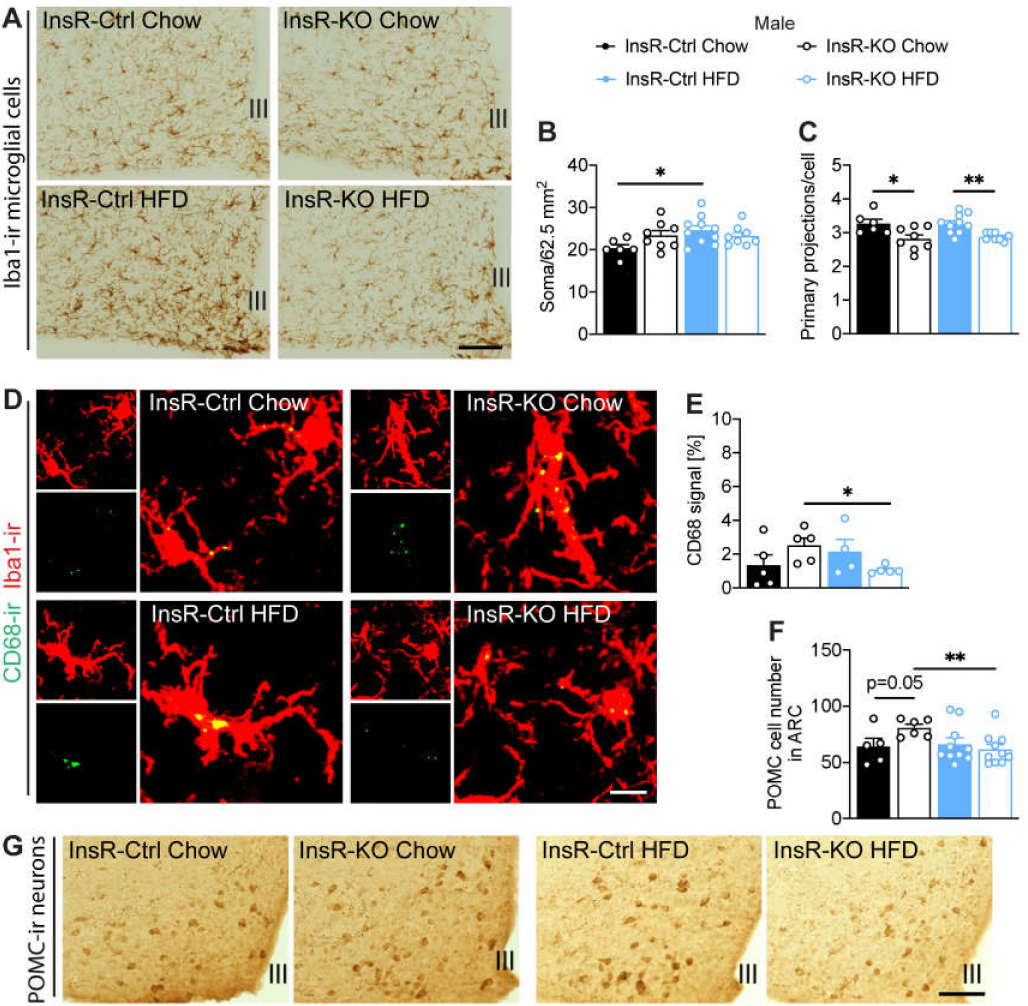
Figure 5. Loss of microglial InsR in male mice leads to impaired microglial morphology, altered phagocytic capacity, and changes in POMC cell number in the arcuate nucleus. ( A ) Iba1-ir microglia in the arcuate nucleus, Iba1-ir ( B ) soma number, and ( C ) primary projections ( n = 6–10). InsR-KO mice had lower primary projections compared to InsR-Ctrl mice, irrespective of diet. ( D , E ) CD68-ir co-localization with Iba1-ir microglia in the ARC ( n = 4–5). ( F , G ) POMC-ir neurons in the arcuate nucleus of male mice ( n = 5–10). There was a borderline significant increase in POMC cell number in InsR-KO male mice, compared to InsR-Ctrl mice under physiological conditions. Data presented for male InsR-Ctrl and InsR-KO mice fed a Chow diet (black) or HFD (blue) following 12 weeks of diet exposure. Data are presented as mean ± SEM. * p < 0.05; ** p < 0.01. III—3rd ventricle. Scale bar: 100 µ m in ( A , G ); 10 µ m in ( D